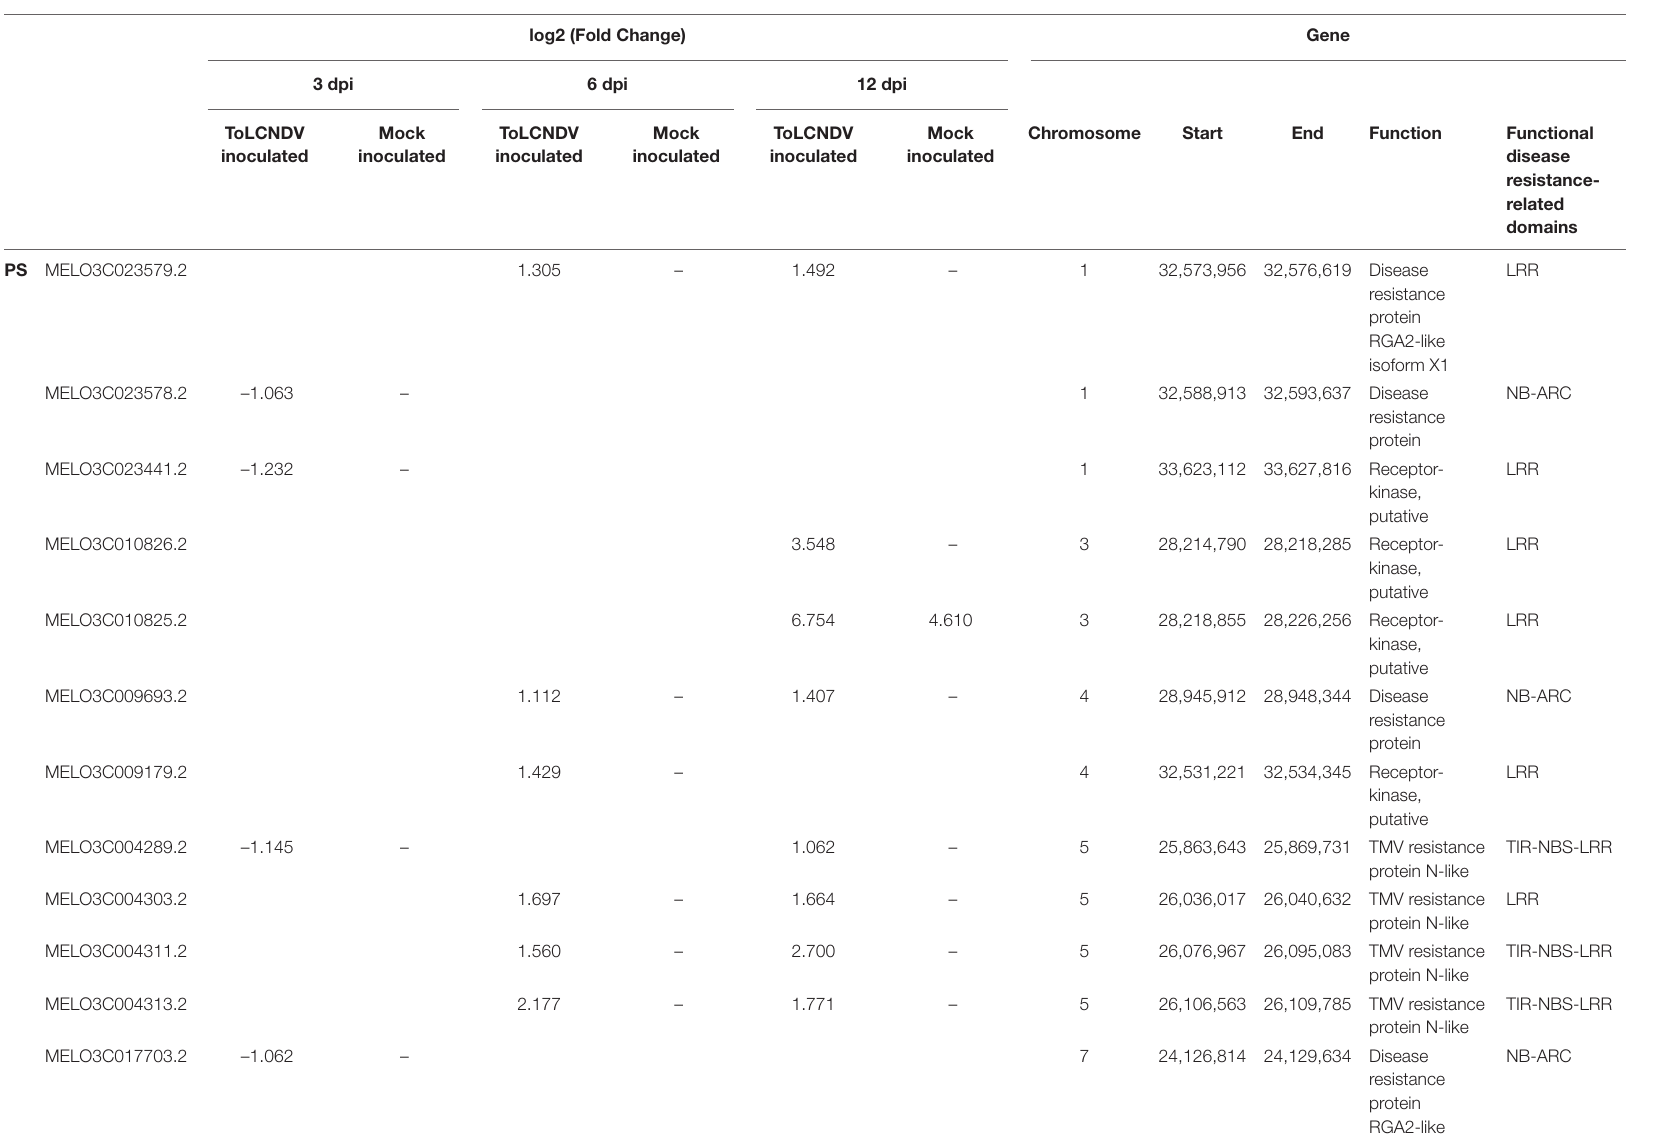
TABLE 3 | Differentially expressed genes identified between the 70 R-genes of the melon genome characterized in Islam et al. (2020).